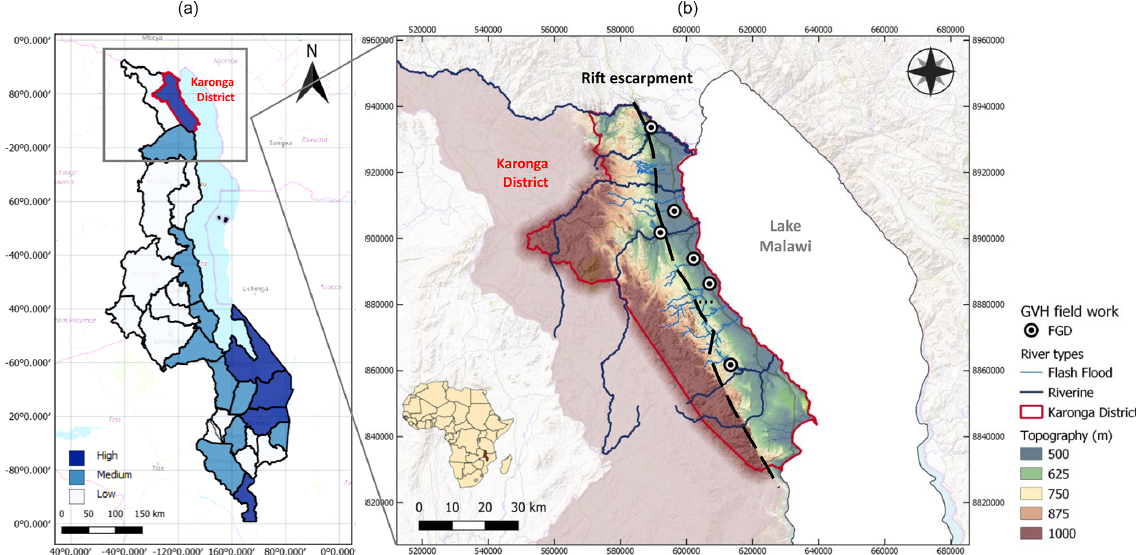
Figure 1. Karonga District location on (a) Malawi flood recurrence map based on observed flood frequency in the period 2000–2013 generated by DoDMA (ICA, 2014). (b) Topography map showing the rift escarpment, the main rivers, and the six visited villages where focus group discussions were conducted for the